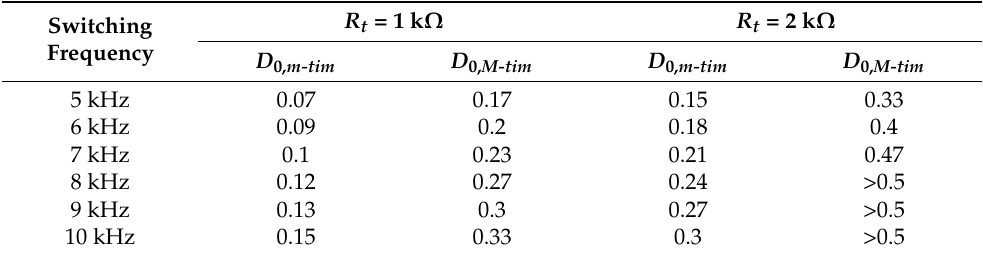
Figure 9. Half-period of the STS as a function of the control voltage obtained for the considered experimental setup. Table 2. The available range of variation of the duty ratio value obtained for the two utilized values of R t resistance.